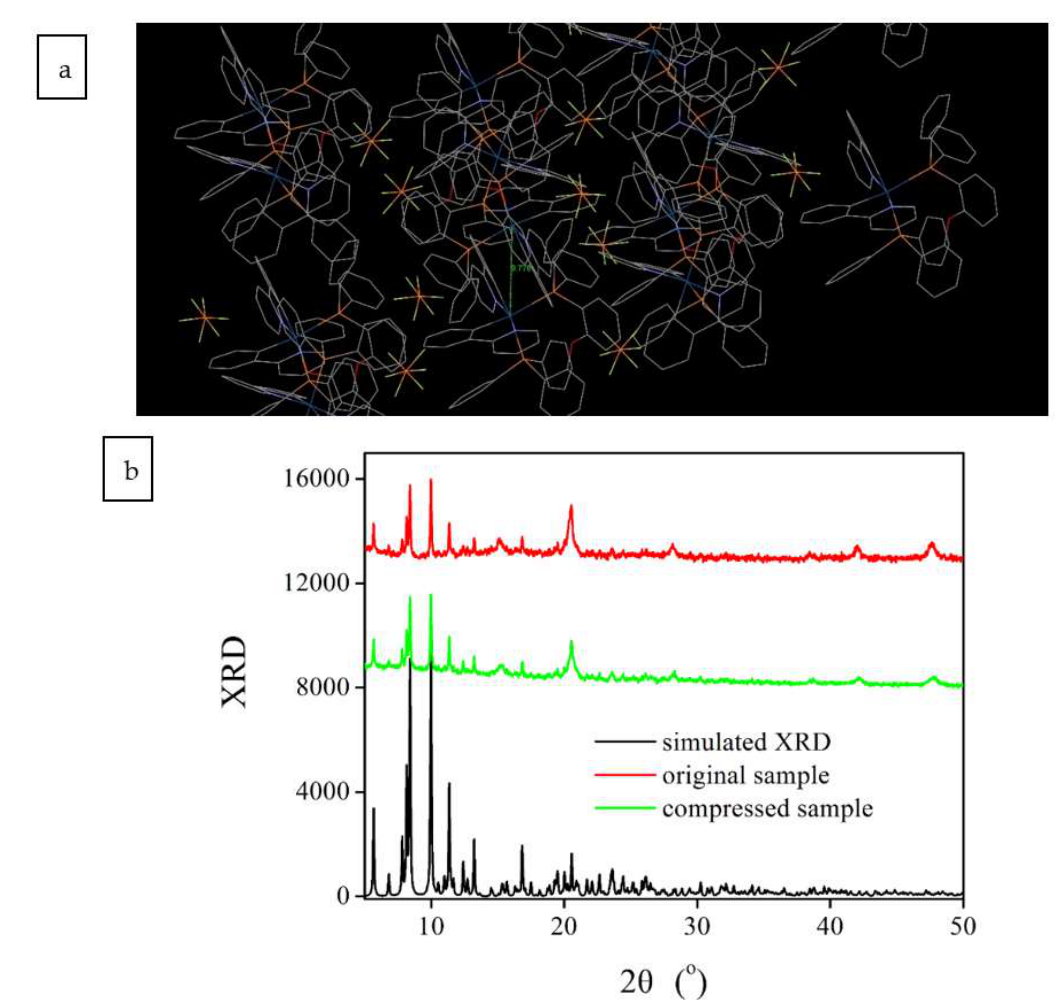
Figure 7. Ir(ppy) 2 (BPE) crystal packing mode ( a ), and XRD patterns of original and compressed Ir(ppy) 2 (BPE) ( b ).